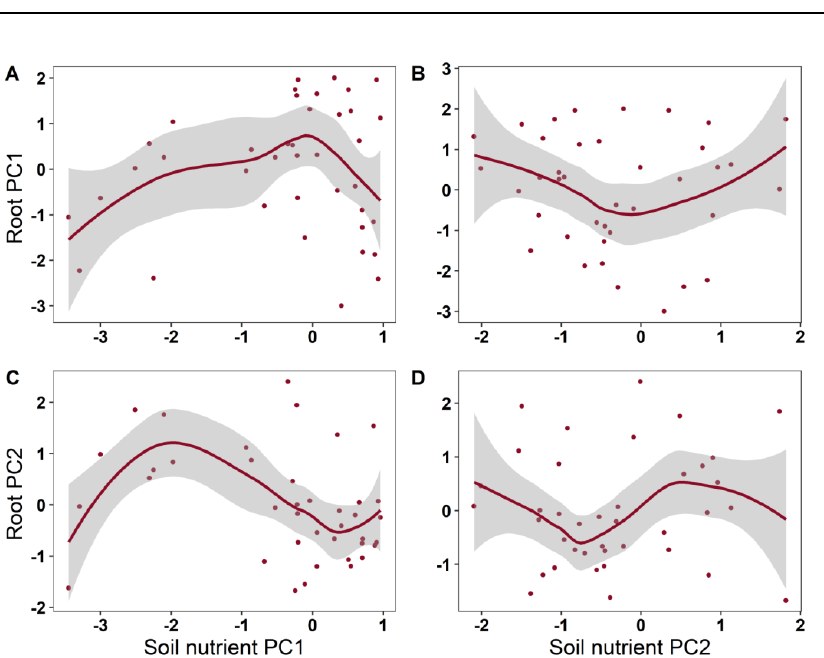
Figure 4. The plots of the GAMs smooth function indicating the effects of soil nutrient factors on leaf nutrient traits. A : soil nutrient PC1 vs. leaf PC1; B : soil nutrient PC2 vs. leaf PC1; C : soil nutrient